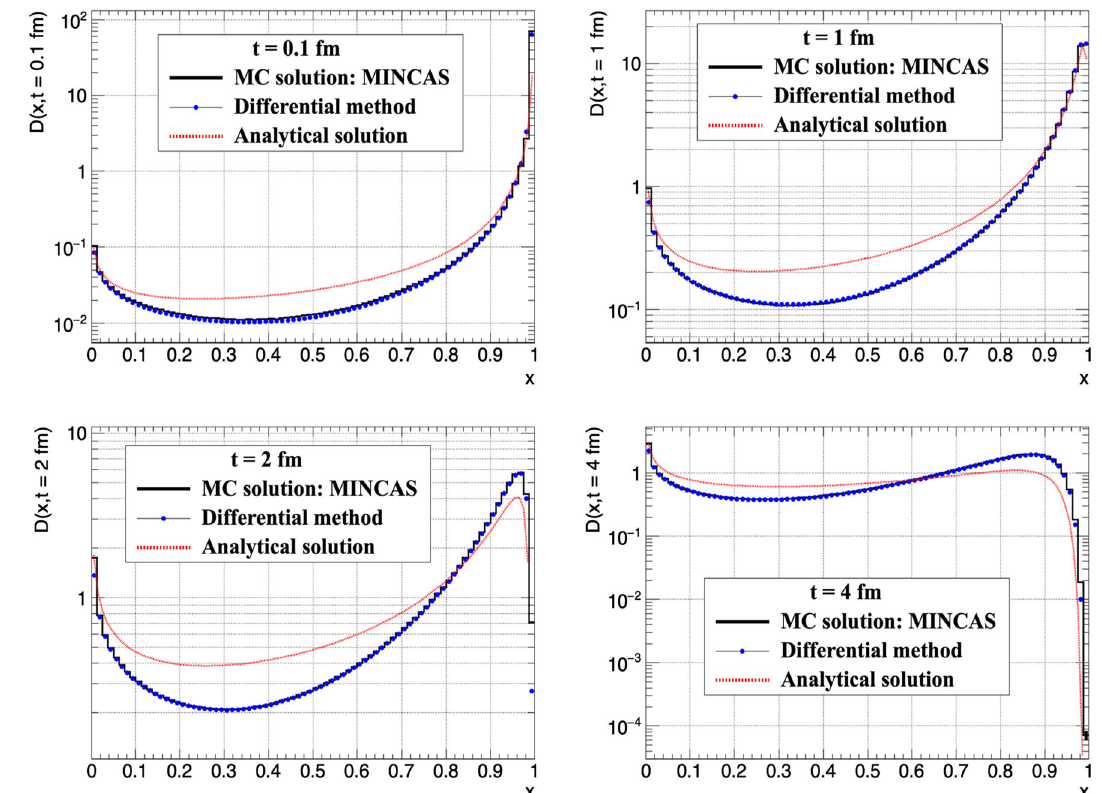
Fig. 2 Comparisons of the x distributions from the Monte Carlo program MINCAS for the solution of Eq. (21) in the case of the exact z -kernel function with the differential method results and the analytical formula of Eq. (8), for the evolution time values: t = 0 . 1 , 1 , 2 , 4fm